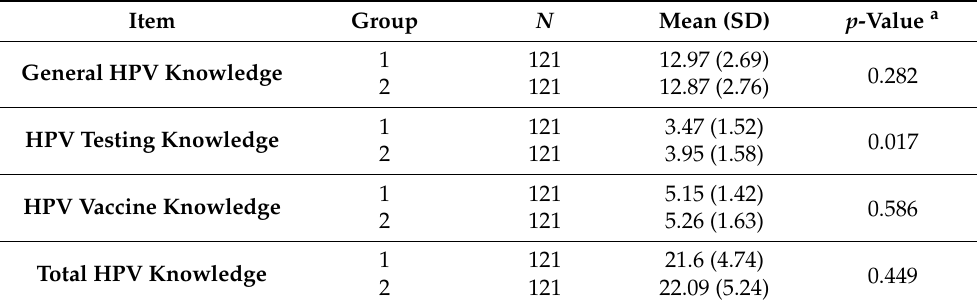
Table 6. Independent sample t -test between groups 1 and 2. Item Group N Mean (SD) p -Value a General HPV